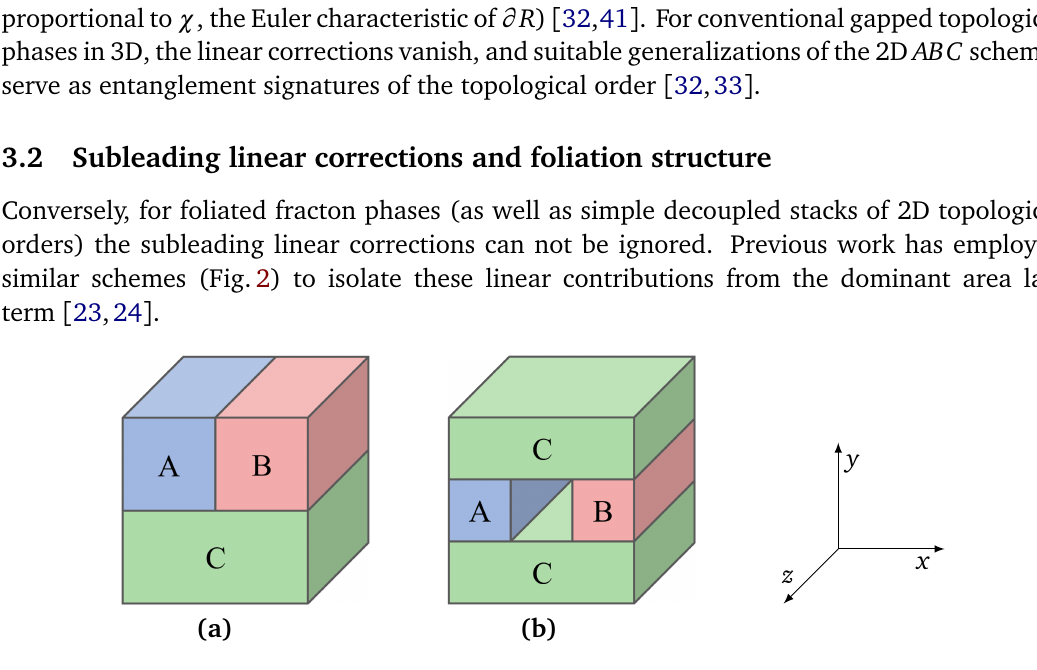
Figure 2: (a) 3D cube I ( A ; B ; C ) and (b) solid torus I ( A ; B | C ) schemes. In both cases the regions are contained within an overall cube of side length L